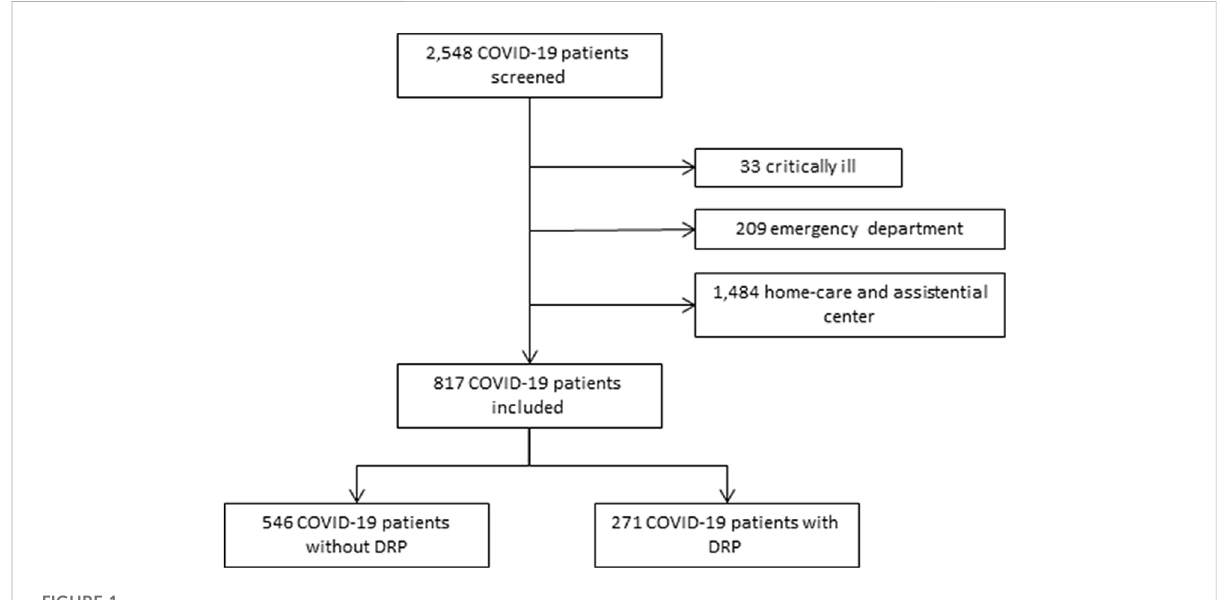
FIGURE 1 Study pro fi